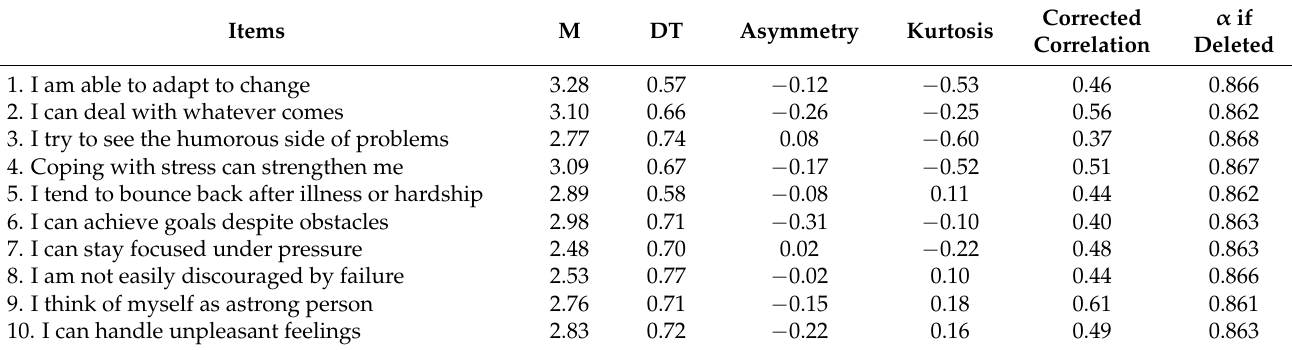
Table 3. Descriptive statistics and corrected item—total correlation for each item.